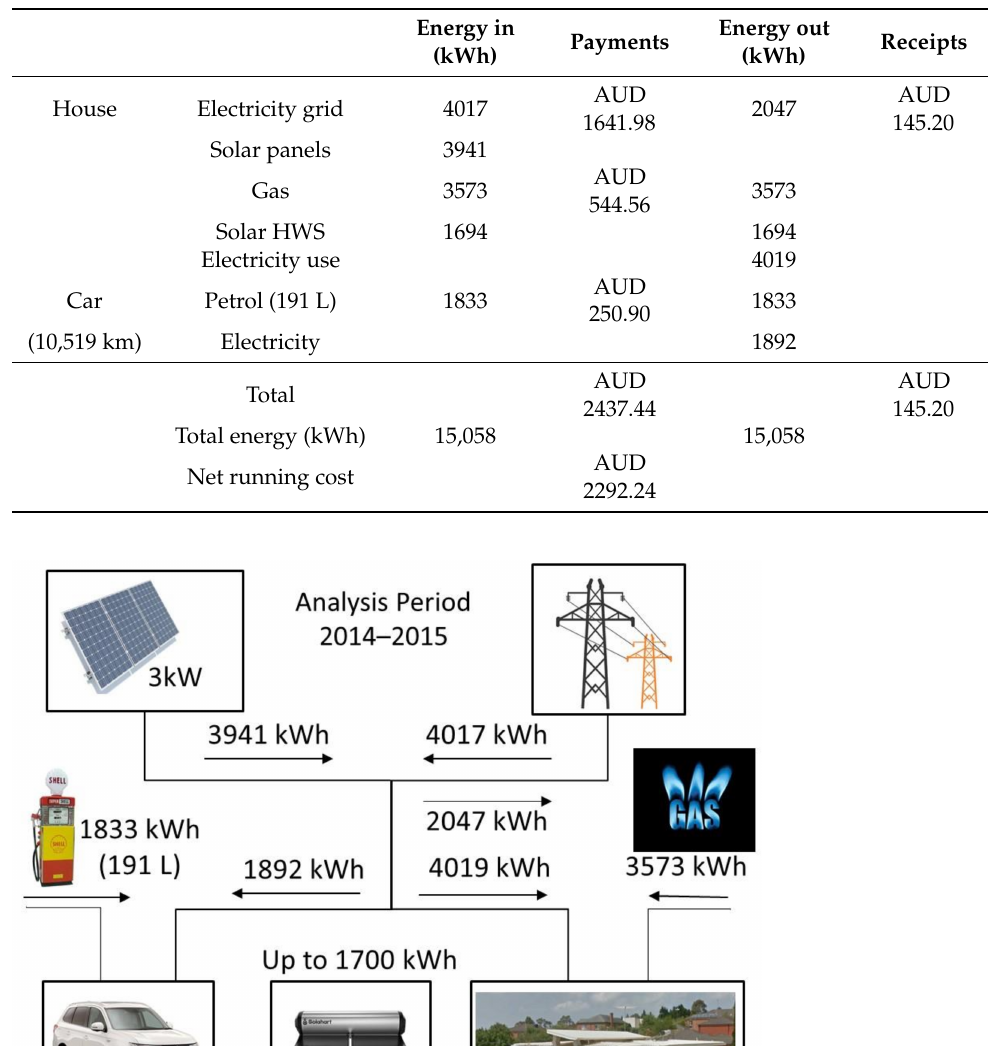
Table 2. Energy use and costs with solar panels and plug-in hybrid vehicle.